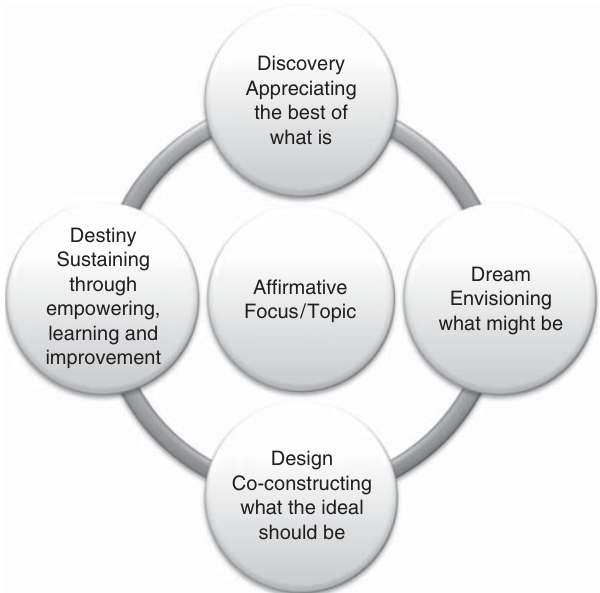
Figure 1. Aspects